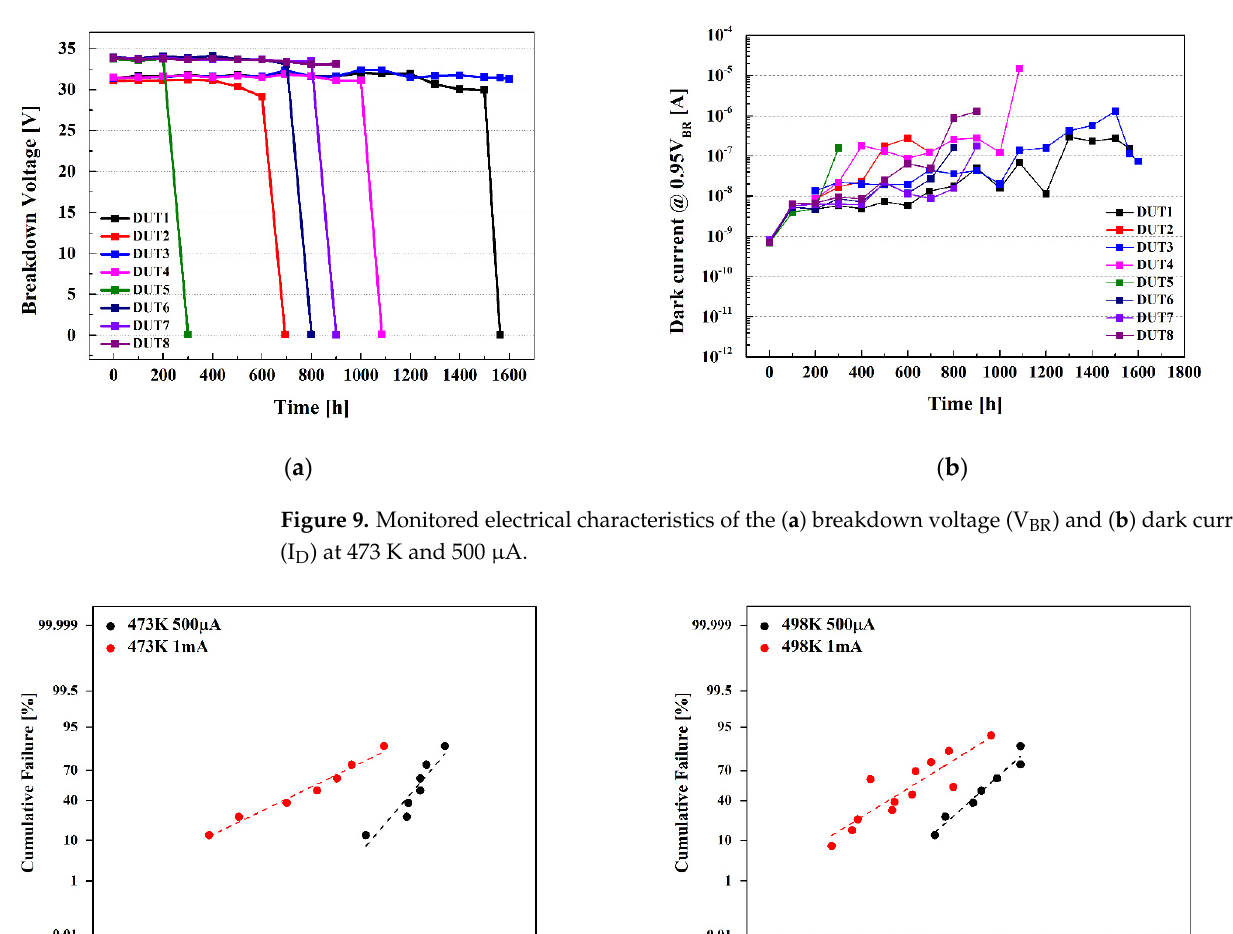
Figure 8. The typical current–voltage (I–V) characteristic degradation of the APDs at 473 K and 500 μ A.